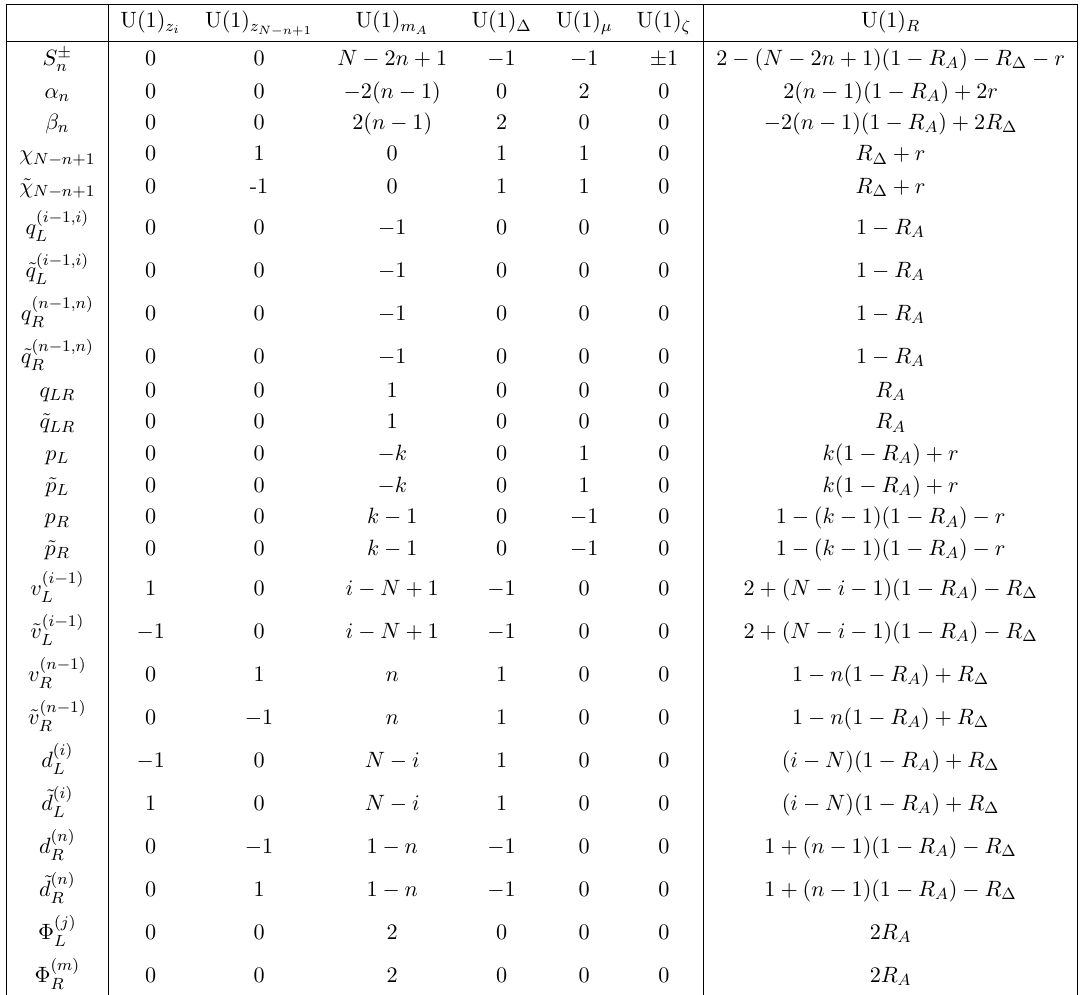
Table 3 . In the table, i runs from 1 to N (cid:0) k , j from 1 to N (cid:0) k (cid:0) 1, n from 1 to k and m from 1 to k (cid:0)